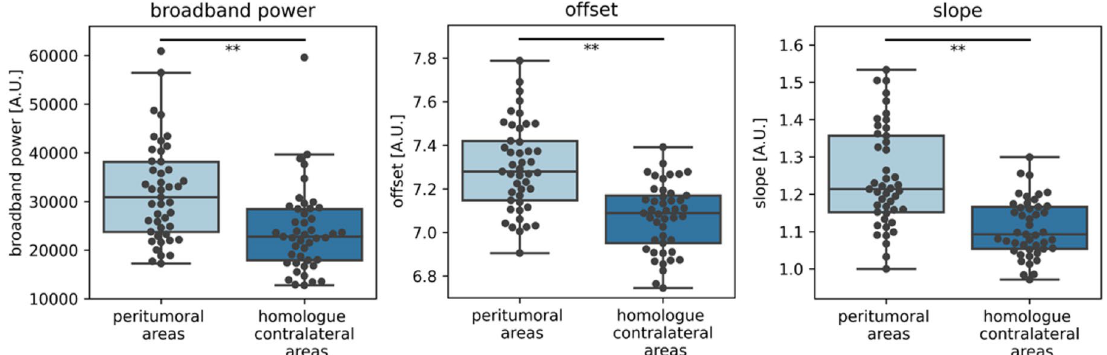
Figure 4. Brain activity of peritumoral and homologue contralateral areas. Peritumoral brain activity was significantly higher compared to the homologue contralateral areas. ** P < 0.001 after correction for three comparisons (broadband power, offset, slope). A.U. = arbitrary